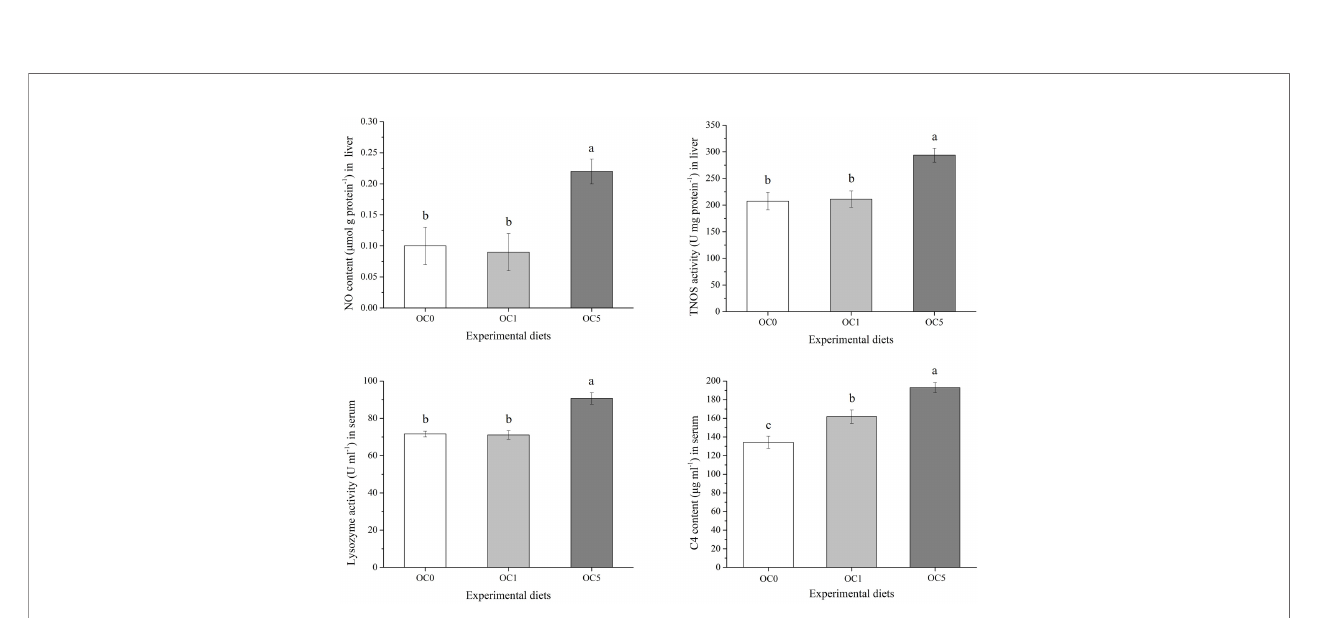
FIGURE 4 | Immune-related parameters in the liver and serum of T. ovatus fed experimental diets. Values were presented as mean ± SE (n = 3). The small letters indicated signi fi cant differences at P <